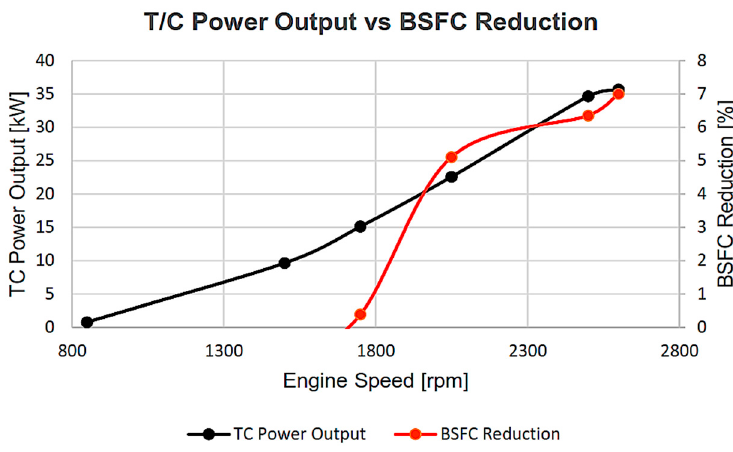
Figure 19. T/C power output vs. BSFC reduction.